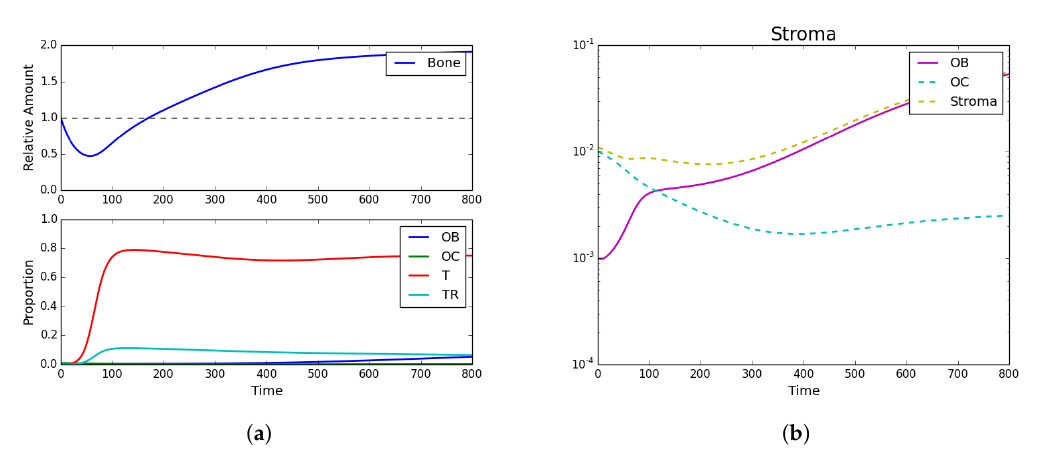
Figure 2. Tumor introduction. ( a ) Bone size and strategy density; ( b ) stroma. Strategy phenotypes in the bottom of ( a ) were observed to be dominated by the tumor phenotype. Subfigure ( b ) and the top of ( a ) showed the characteristic PCa takeover of the bone remodeling complex and the resultant vicious cycle causing dramatic bone growth.